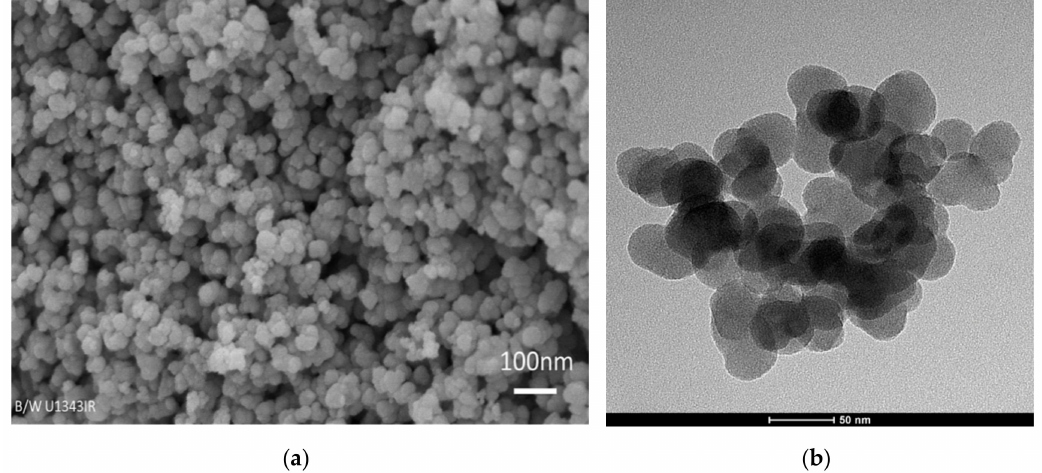
Figure 6. ( a ) Scanning electron microscopic image of the CNPs, ( b ) TEM image of